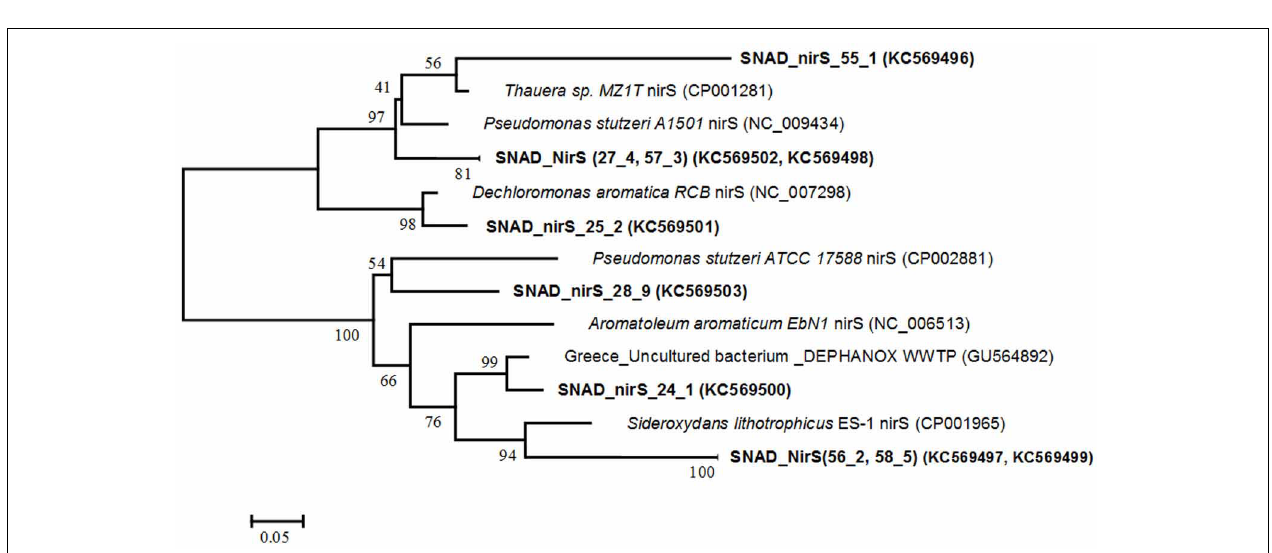
with the Jukes-Cantor model. The analysis involved 21 nucleotide sequences. Evolutionary analyses were conducted in MEGA.5. The numbers at the nodes indicate the levels of bootstrap support (based on data for 500 replicates) for groups to the right of the nodes. The scale bar represents 0.5% estimated sequence divergence.